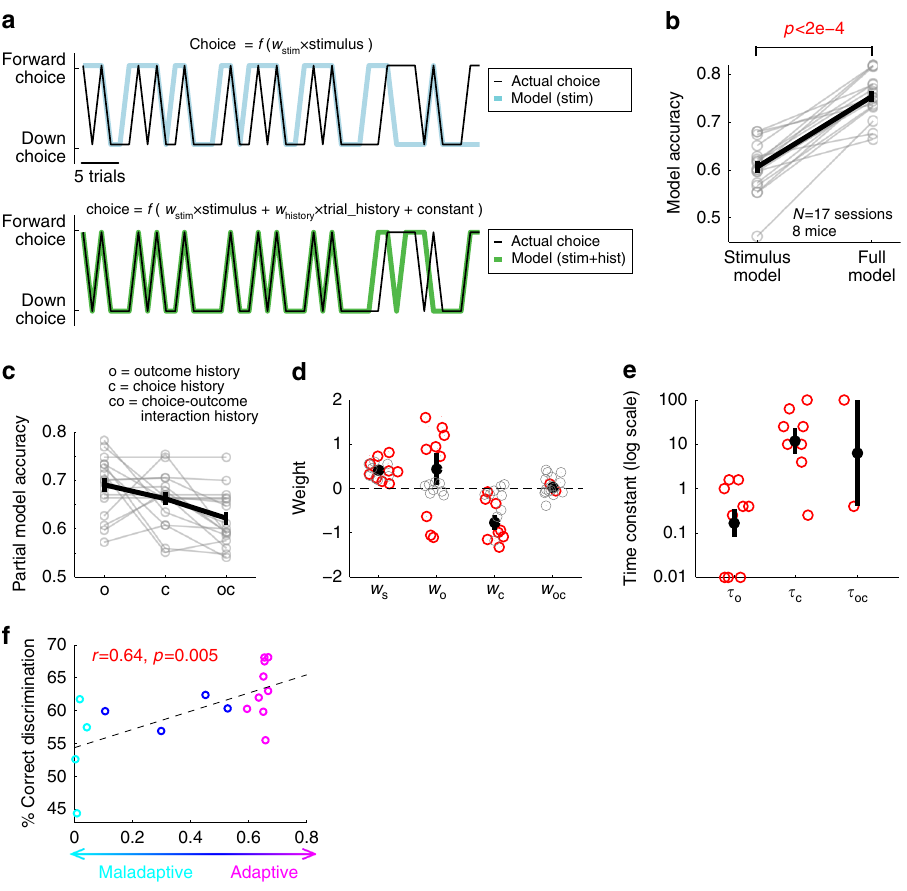
Fig. 2 Choice-outcome history biases future decision, driving choice variability. a Top: example trial-by-trial sequence of an animal ’ s choice (black) with partial model fi t using stimulus information only (cyan). Bottom: choice sequence from top plot (black) with full model fi t using stimulus, trial history, and a constant (green). b Full model including both stimulus and history information predicts choice more accurately than partial model with stimulus only. Black, mean ± s.e.m. across sessions; gray, individual sessions. Wilcoxon one-sided signed rank test. c Partial model accuracy using only one history variable (outcome, choice, or outcome-choice interaction) at a time, indicating that outcome history and choice history have large contributions to model accuracy. Black, mean ± s.e.m. across sessions; gray, individual sessions. d Weight of each variable. Red circles indicate sessions in which the corresponding partial model (with the variable and a constant) is signi fi cantly better than the model with only a constant (likelihood-ratio test between the partial and constant models, p < 0.05), while gray circles indicate the other sessions. Black, mean ± s.e.m. across signi fi cant sessions. e Time constant of each history variable. Sessions are included only if the corresponding partial model (with one history variable and a constant) is signi fi cantly better than the model with only a constant (likelihood-ratio test between the partial and constant models, p < 0.05). Black, mean ± s.e.m. across sessions; gray, individual sessions. f History- dependent strategies are classi fi ed as maladaptive (cyan), neutral (blue), or adaptive (magenta) depending on the fraction of correctly discriminating trials achieved by the estimated history models (using only history but not stimulus) relative to chance ( p < 0.05, Experimental Procedures). Sessions with adaptive strategies tend to be associated with better behavioral performance (Pearson correlation coef fi cient = 0.64, p <